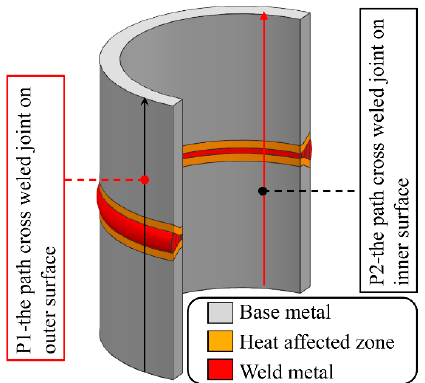
Figure 9. Illustration for paths used for residual stress